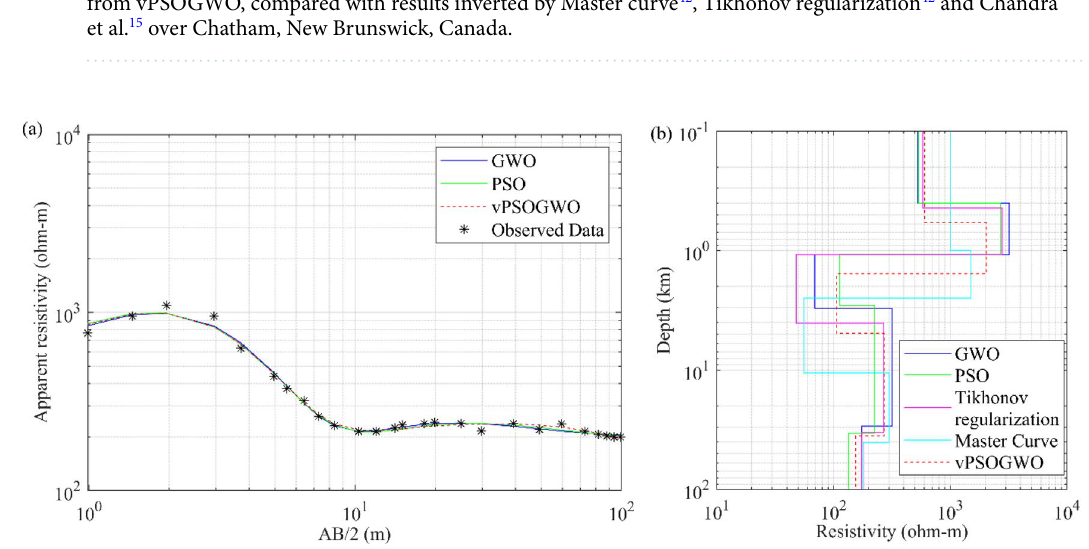
Figure 14. Five-layers DC field data over Chatham, New Brunswick, Canada: ( a ) observed (*) and the best- fitted apparent resistivity curve using GWO, PSO, and vPSOGWO; ( b ) 1-D mean model (bpdf > 68.27% CI) inverted by vPSOGWO (red), Master Curve (cyan), Tikhonov regularization (magenta), PSO (green) and GWO